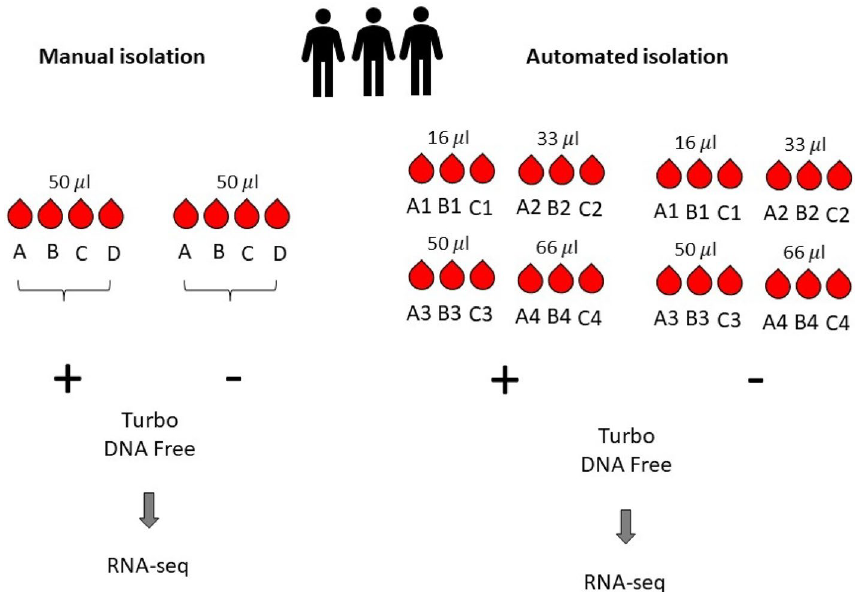
Figure 1. Outline of the RNA samples isolated in this study for the manual and automated